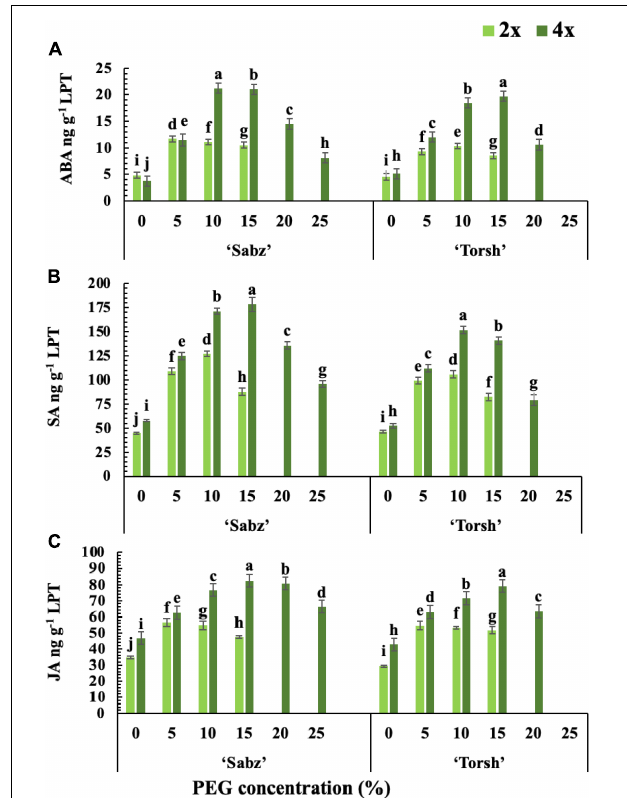
FIGURE 3 | The cumulative biosynthesis amount of three main stress response phytohormones in tetraploid and diploid explants of ‘Sabz’ and ‘Torsh’ fig cultivars 14 days after subjecting to different water stress treatments. (A) Abscisic acid, (B) salicylic acid, and (C) jasmonic acid. LPT, lyophilized tissue. Means represent the ploidy level and PEG treatment effects tested by two-way ANOVA. Each value represents the means ± SE. Different letters indicate significant differences at P < 0.05 using the LSD